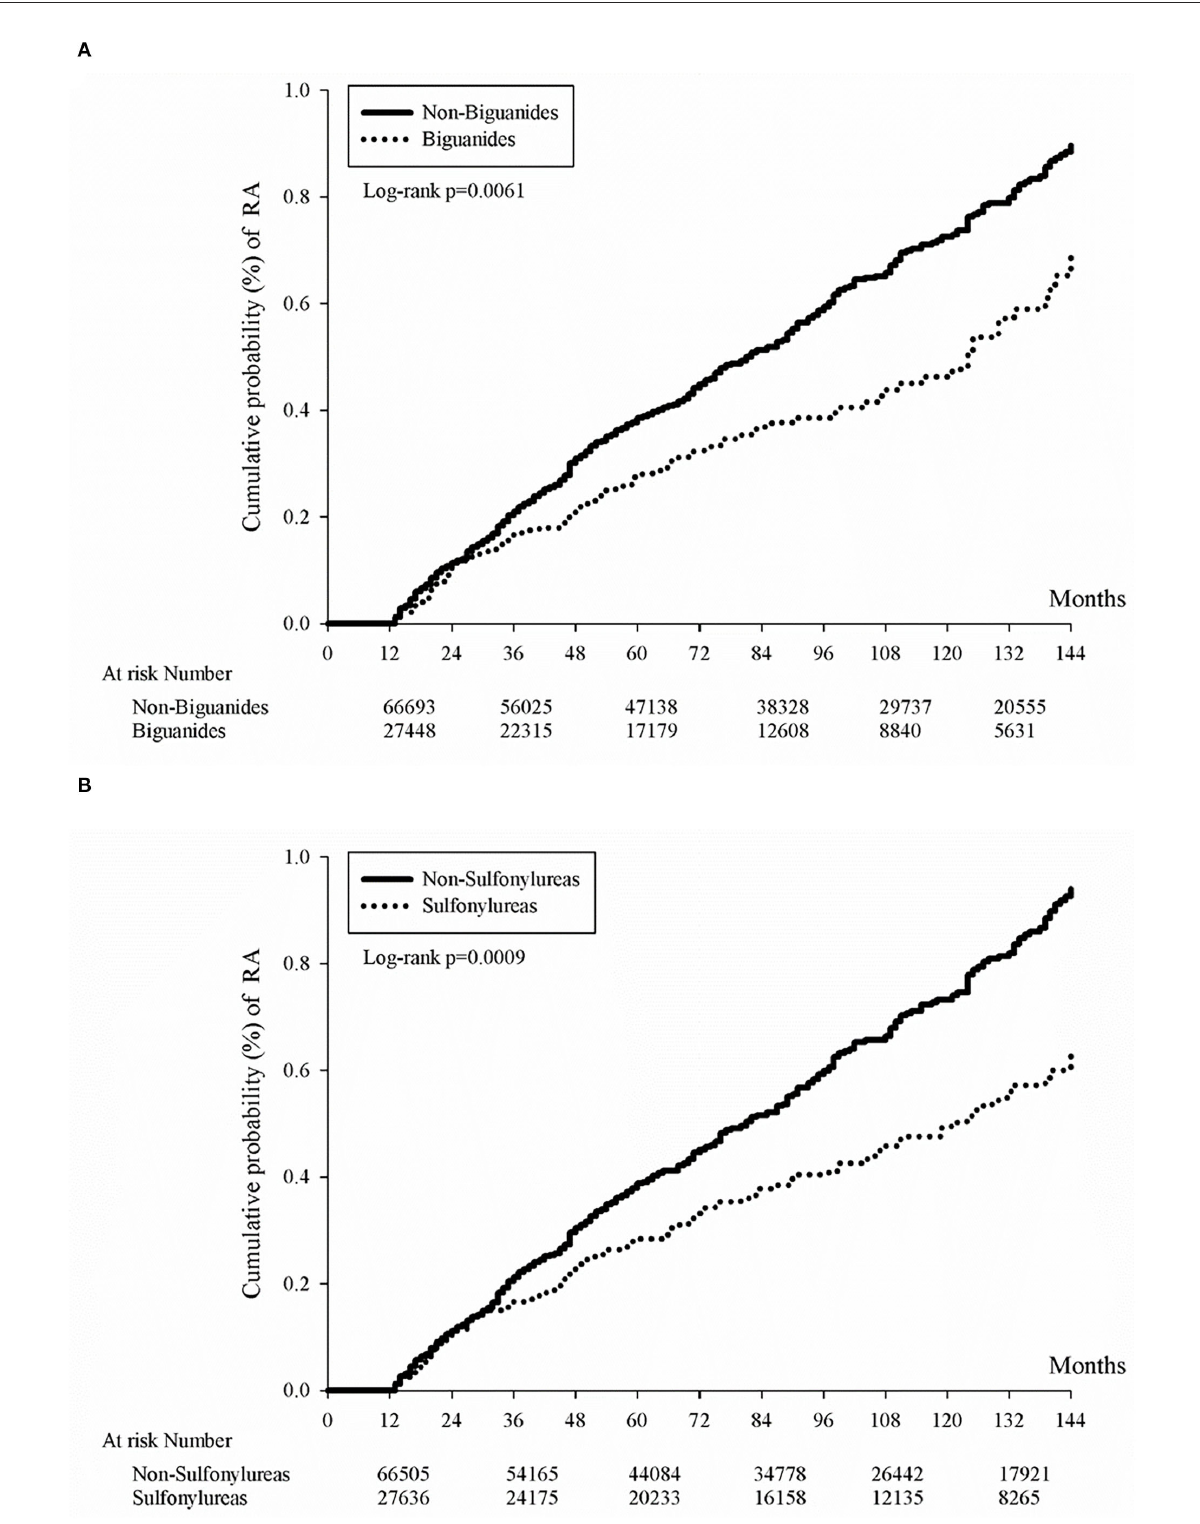
FIGURE2 Kaplan-Meier curves of cumulative rheumatoid arthritis incidence proportion in diabetes patients by oral anti-glycemic agent. Kaplan-Meier curves of cumulative rheumatoid arthritis incidence proportion in diabetes patients by the use of either biguanides (A) or sulfonylureas (B) . Either biguanides users or sulfonylureas users had lower cumulative rheumatoid arthritis incidence rates (p = 0.0061 for biguanides users and p = 0.0009 for sulfonylureas